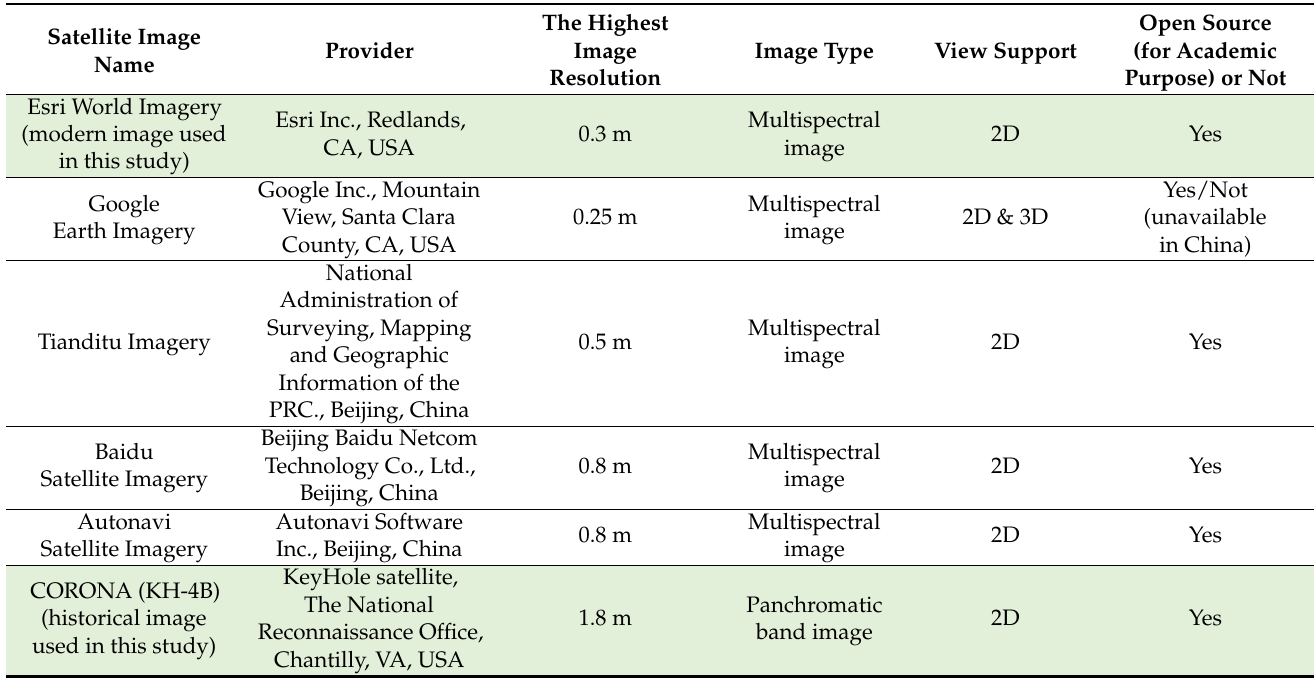
Table 1. List of commonly used satellite image